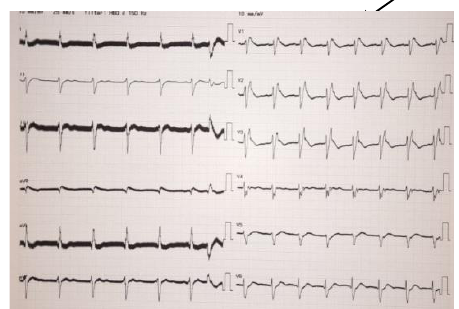
Figure 2. P atient’s second ECG showed symmetrically in- verted T-waves and probable epsilon waves in the right precordial leads, mimicking a pseudo-right bundle branch block (RBBB)